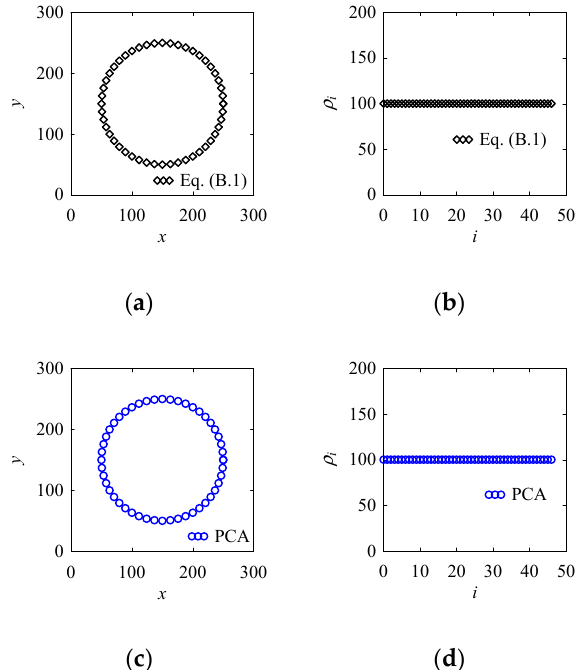
Figure 11. Circle shapes and their radii of curvature. ( a ) Point cloud of a circle modeled by a parametric equation; ( b ) radius of curvature of ( a ); ( c ) point cloud a circle modeled by the PCA; ( d ) radius of curvature of ( c ).